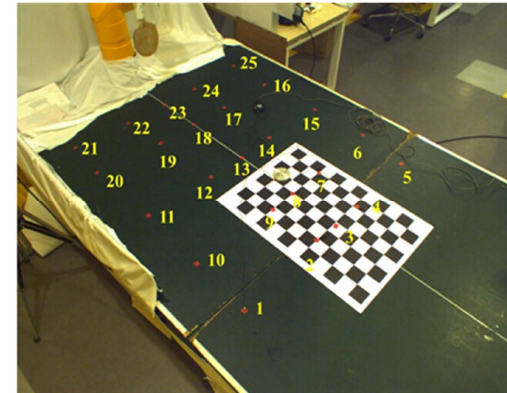
Figure 8. Locations of 25 trackers.